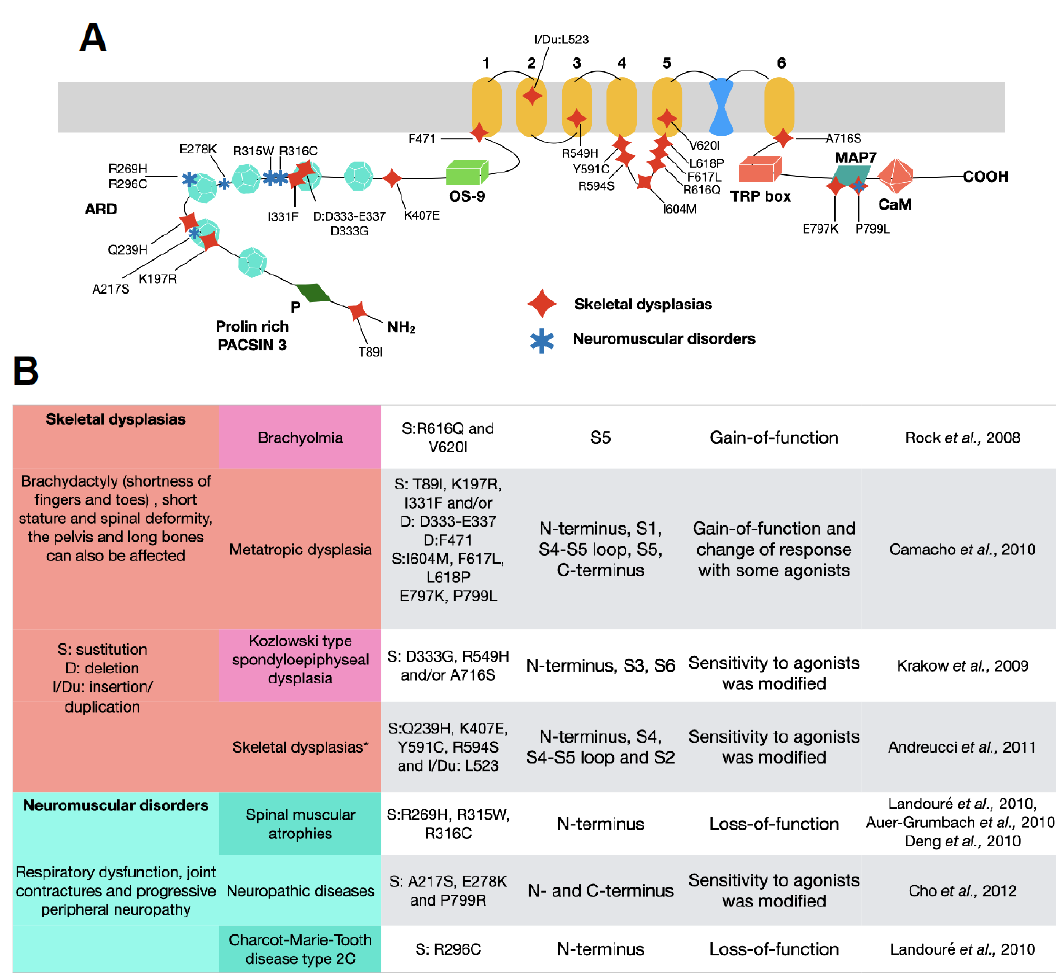
Figure 5. Location of mutations in different regions of the TRPV4 structure that produce skeletal dysplasia and neuromuscular disorders. ( A ) The top panel represents a subunit of the TRPV4 channel. I/Du = Insertion/Duplication. ( B ) The bottom panel summarizes the data in the top panel and the type of disease they produce as well as the effect of the mutation in channel function. PACSIN 3, protein kinase C and casein kinase substrate in neurons protein 3; ARD, ankyrin repeat domain; OS-9, osteosarcoma 9; TRP box, Transient Receptor Potential box; MAP7, microtubule associated protein 7; CaM, calcium calmodulin.